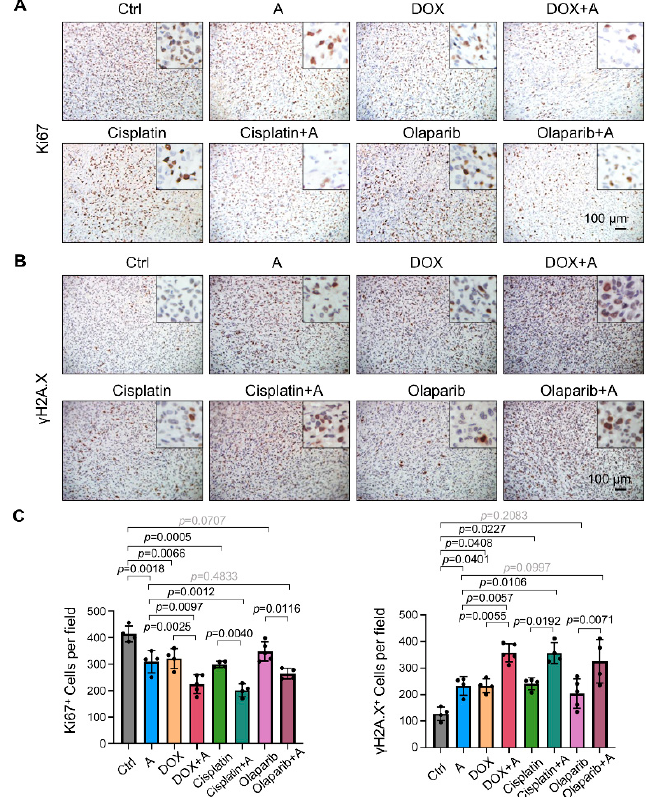
Figure 13. Chemical A enhances the effects of chemotherapeutic drugs on proliferation inhibition and DNA damage induction. Nude mice bearing MDA-MB-231 cells were administered chemical A in combination with doxorubicin, cisplatin, and olaparib from 10 to 31 dpi. ( A ) Representative images showing immunohistochemical staining for Ki67 of tumors dissected at 31 dpi. ( B ) Representa- tive images showing immunohistochemical staining for γ H2A. X of tumors dissected at 31 dpi. ( C ) Immunohistochemical staining results in ( A , B ) were quantitatively compared. n = 4–5. Scale bars, 100 μ m. The lines and error bars indicate the means ± s.e.ms.; one-way ANOVA with Tukey’s mul- tiple comparisons test.